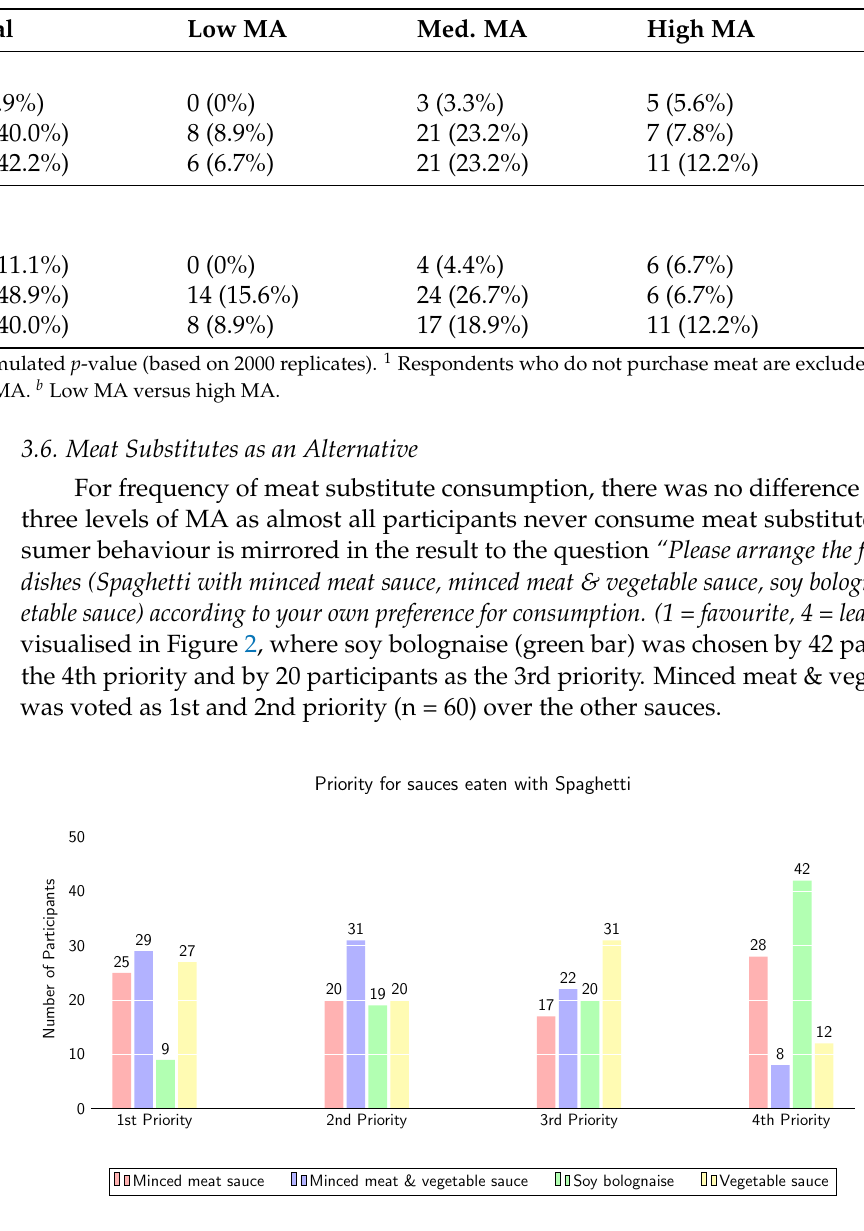
Table 3. Purchasing behaviour of the total study population and the members of the groups low, medium and high meat attachment (MA) regarding meat and plant-based food. p -values show differences between groups, statistical significant results are marked with a star.